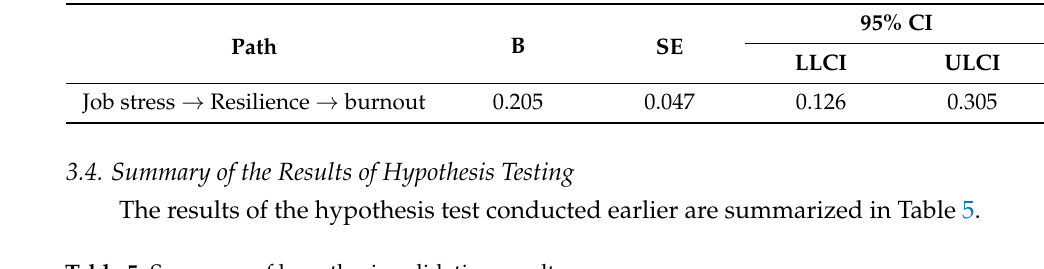
Table 5. Summary of hypothesis validation